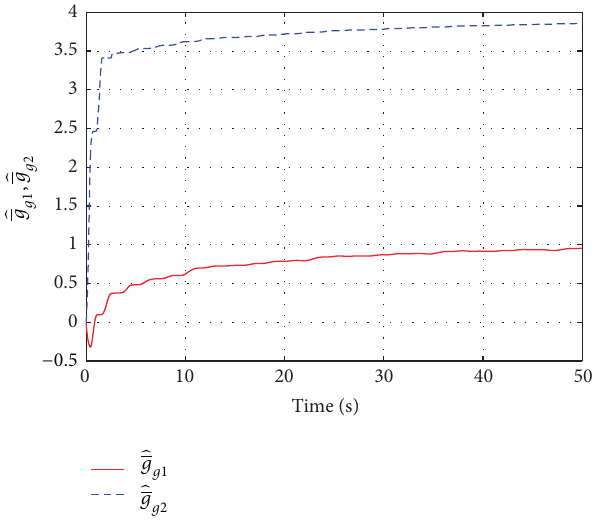
̂𝑔 𝑔 1 (real line) and